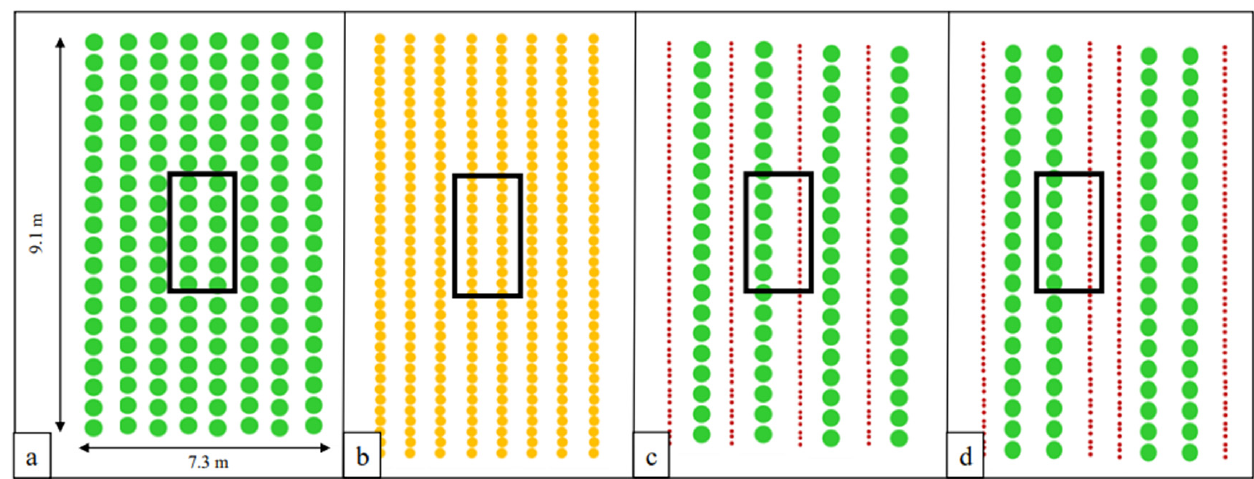
Figure 1. Visual representation of crop densities, sampling area, and plot size for each planting arrangement for maize, cotton, and soybean. Within the rows, green circles represent the normal planting density, yellow circles represent doubled planting density, and red circles represent tripled planting density. Each crop had four planting arrangements on eight, evenly spaced rows shown as followed: ( a ) normal density in all rows, considered the control, ( b ) doubled density in all rows, ( c ) a sequential arrangement of normal and tripled densities, and ( d ) normal-tripled-tripled-normal. Dark squares located in the center of each plot are the locations in which samples were taken for data collection to prevent a border effect. Plot sizes are for the Rocky Mount location.